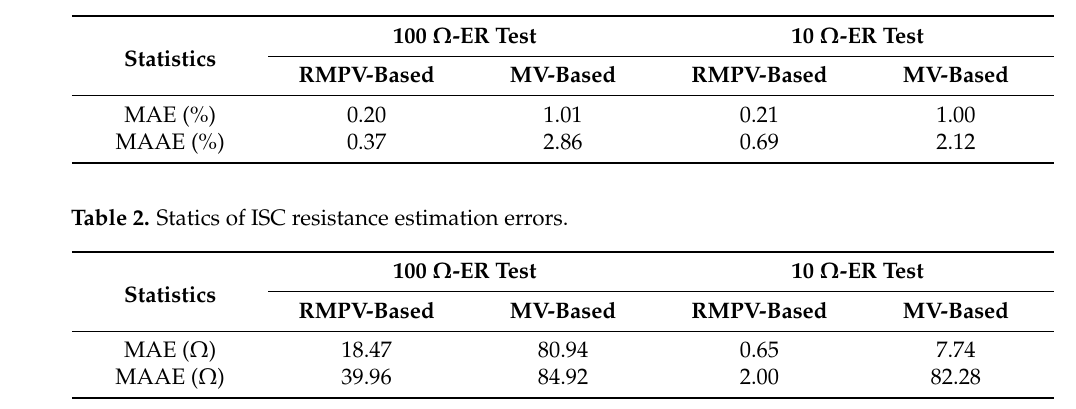
Table 2. Statics of ISC resistance estimation errors. Table 1. Statics of SOC estimation errors.